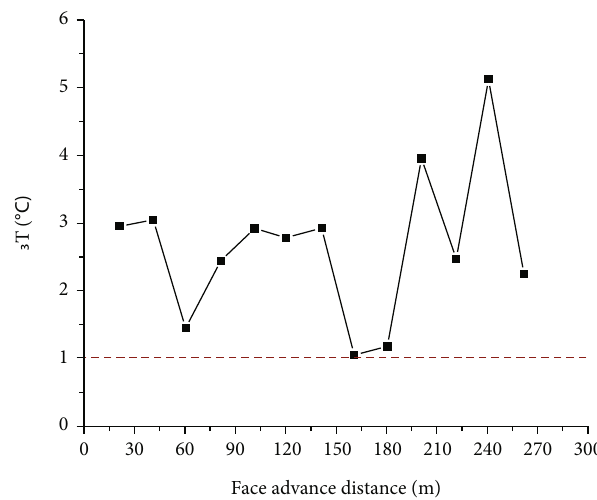
Figure 13: Evolution curve of temperature di ff erence of overburden migration failure